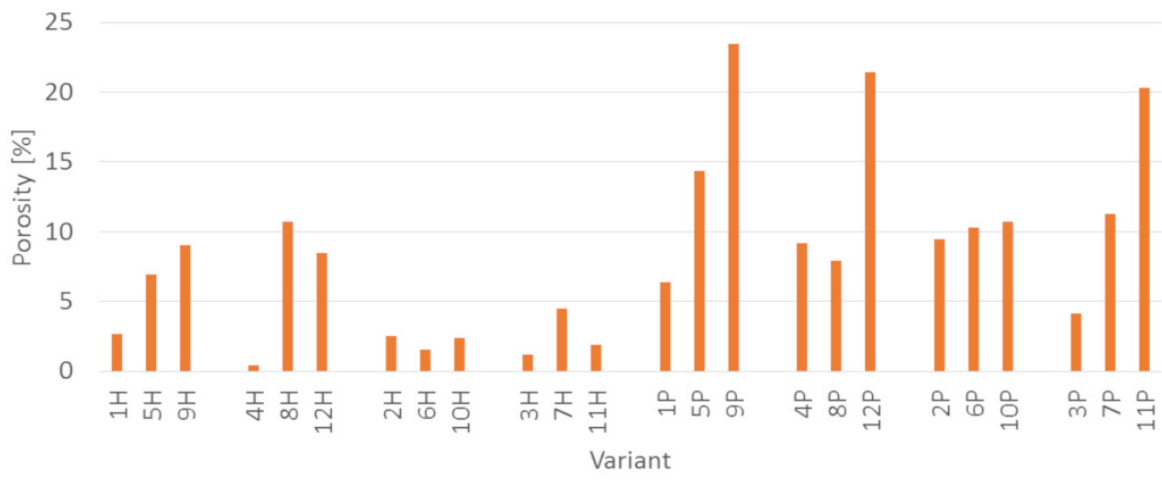
Figure 7. Porosity of the tested PLA and HDPE composites.